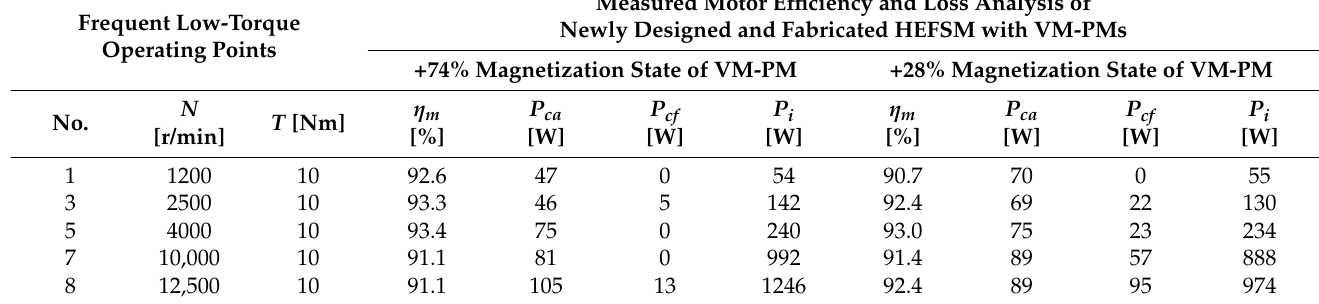
Table 8. Measured motor efficiency and loss analysis